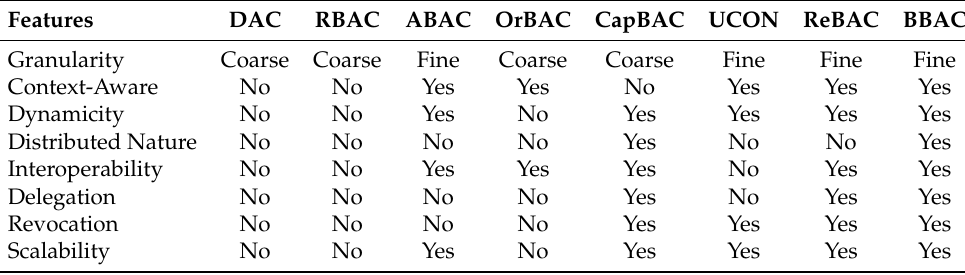
Table 1. Access Control Models and